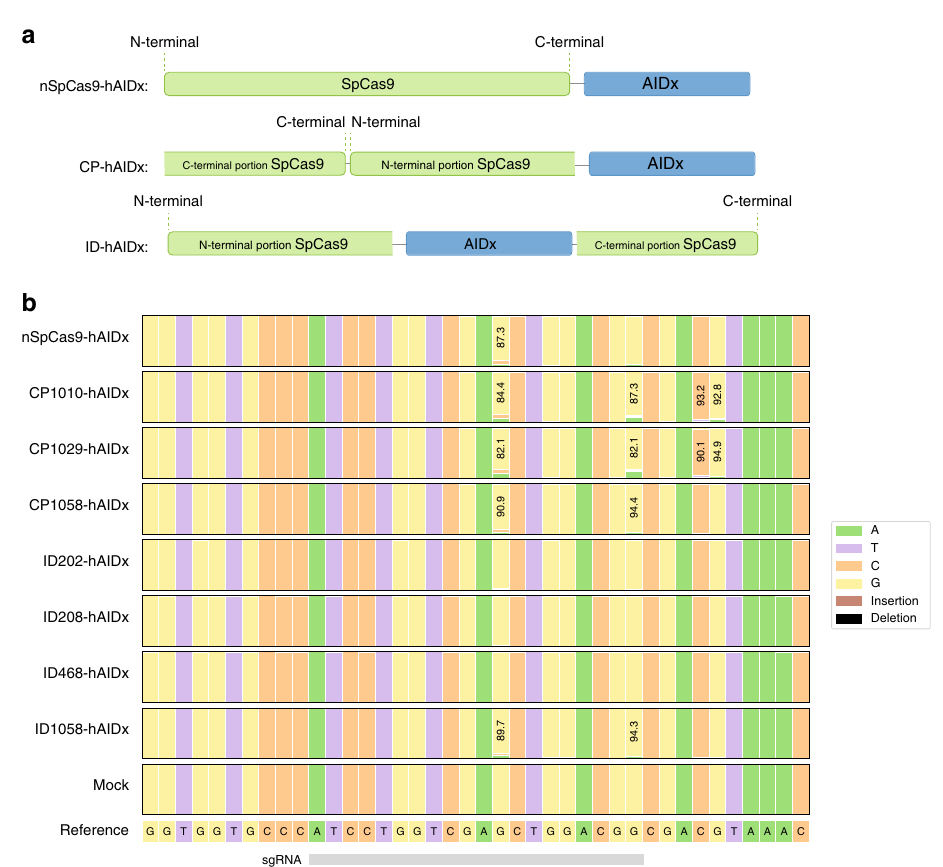
Fig. 1 Activity pro fi le of nSpCas9-hAIDx permutations. a Schematic overview of nSpCas9-hAIDx constructs investigated. Here nickase SpCas9 is displayed in green, with cytosine base editors (CBE) shown as a dark blue stadium. b Nucleotide quilt of the N-terminal linked hAIDx and circularly permuted (CP) or intradomain (ID) SpCas9 constructs targeting the YFP locus. Here, the editing ef fi ciencies and product purities have been averaged across three technical replicates. Source data are available in the Source data fi